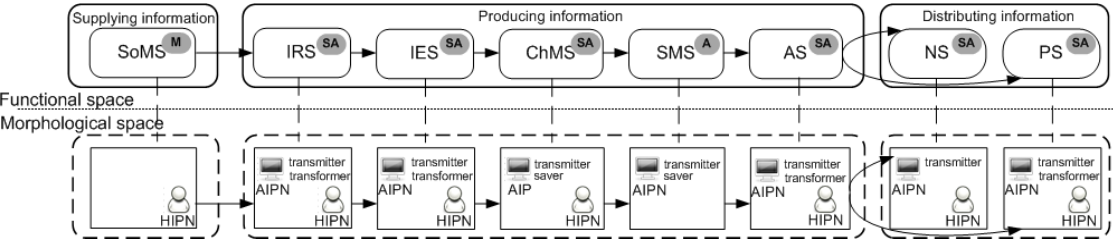
Figure 9. Multimode logistics (simplified: the relationships between multiple sub-elements of the nodes are not shown in the morphological space of